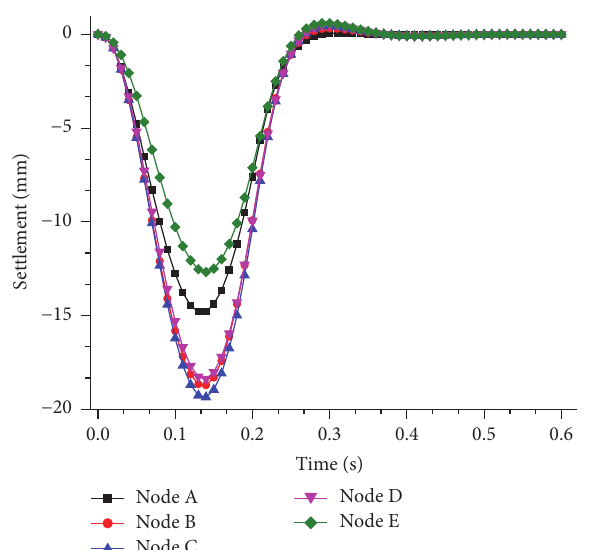
Figure 11: Slope time-history analysis settlement displacement curve.